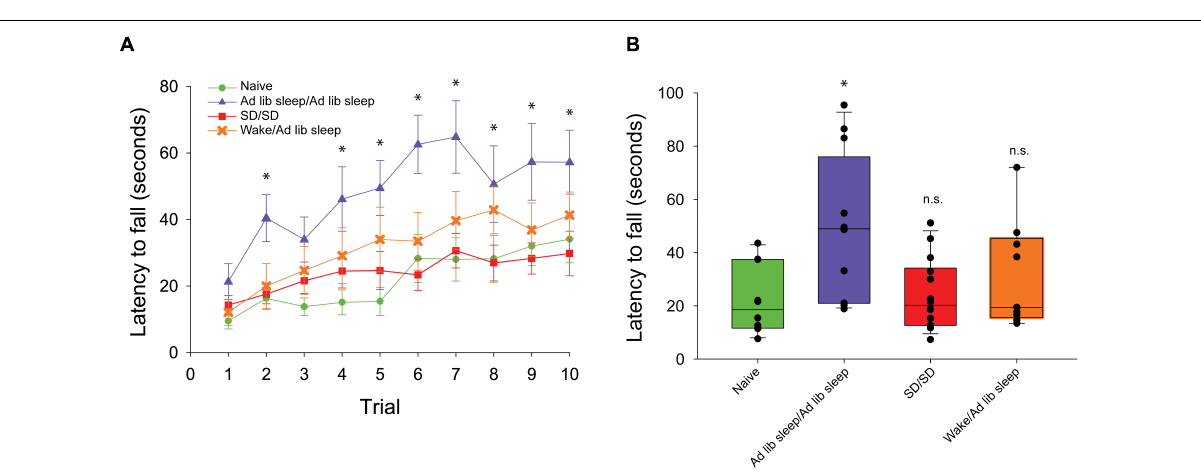
FIGURE 2 | Rotarod performance during exclusive backward running. (A) Latency to fall is measured across 10 consecutive trials. Mice experiencing exclusive forward running template learning over 2 days followed by ad libitum sleep (blue triangle, n = 12) demonstrated significantly better backward running performance than mice experiencing exclusive forward running template learning over 2 days followed by 10 h of sleep disruption (SD) (red square, n = 14), mice experiencing exclusive forward running template learning separated by 30 min of natural wake prior to ad libitum sleep (orange X, n = 9), or mice naïve to running exclusively backward (green circle, n = 10). (B) Box plots showing the average exclusive backward running performance over 10 trials between sleep conditions. ∗ p < 0.05, n.s. = not